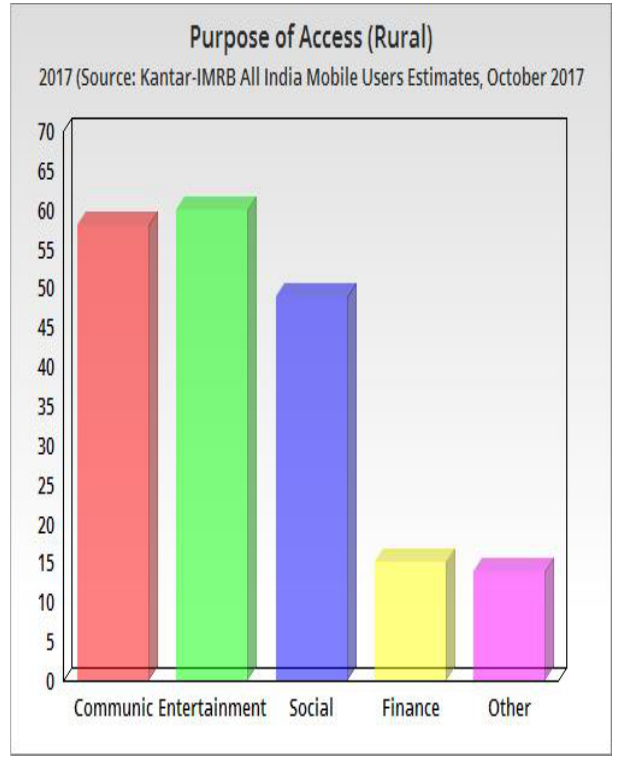
Figure 2. Reasons for accessing Internet via. mobile